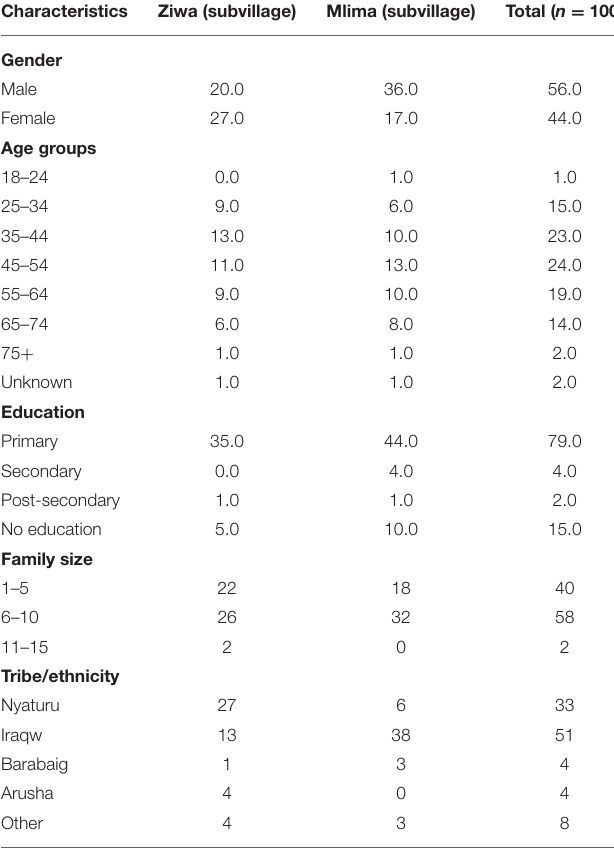
TABLE 2 | Respondent characteristics in